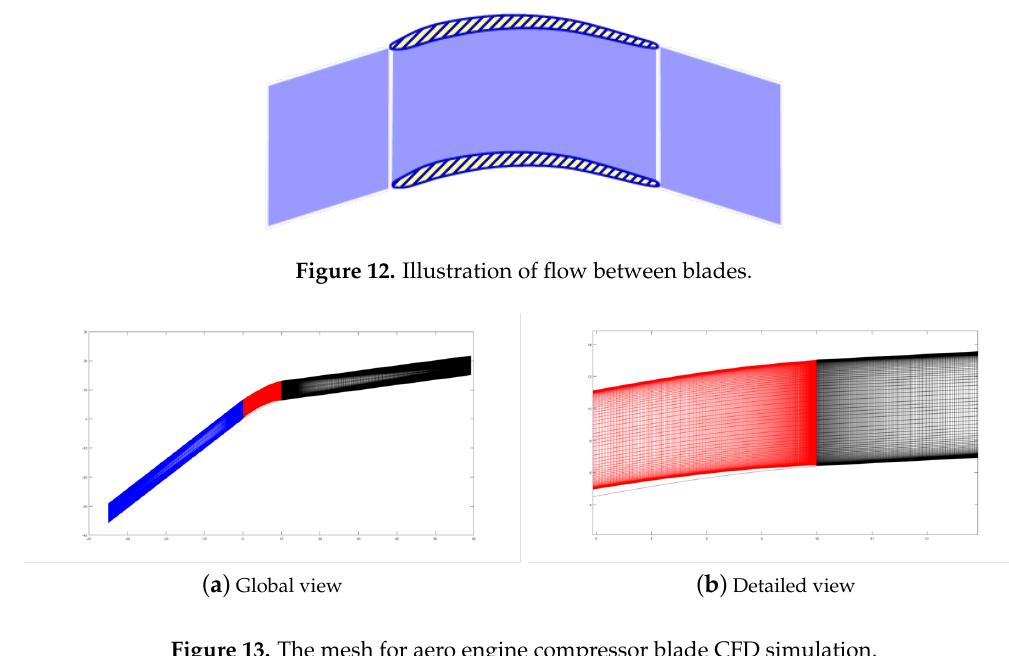
Figure 13. The mesh for aero engine compressor blade CFD